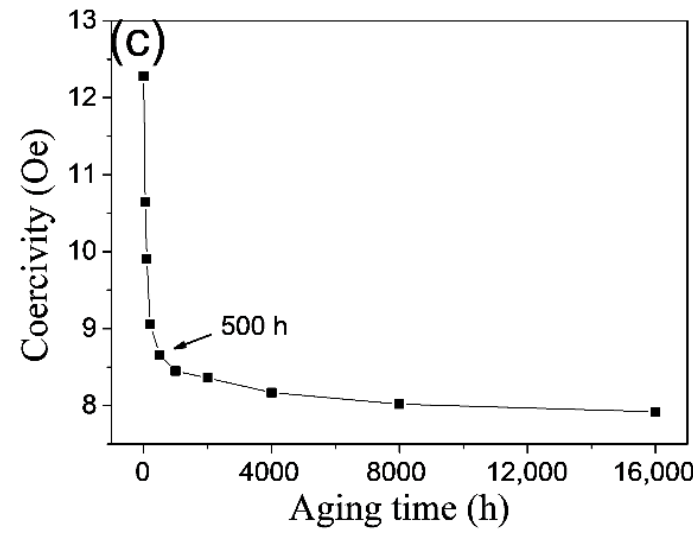
Figure 1. ( a ) Hysteresis loops of P91 steels processed by aging at 675 °C for different durations. ( b ) The magnification of the hysteresis loops around the zero point. ( c ) Coercivity of P91 steels thermally aged for various times. Coercivity is the magnetic field when the magnetization is zero.